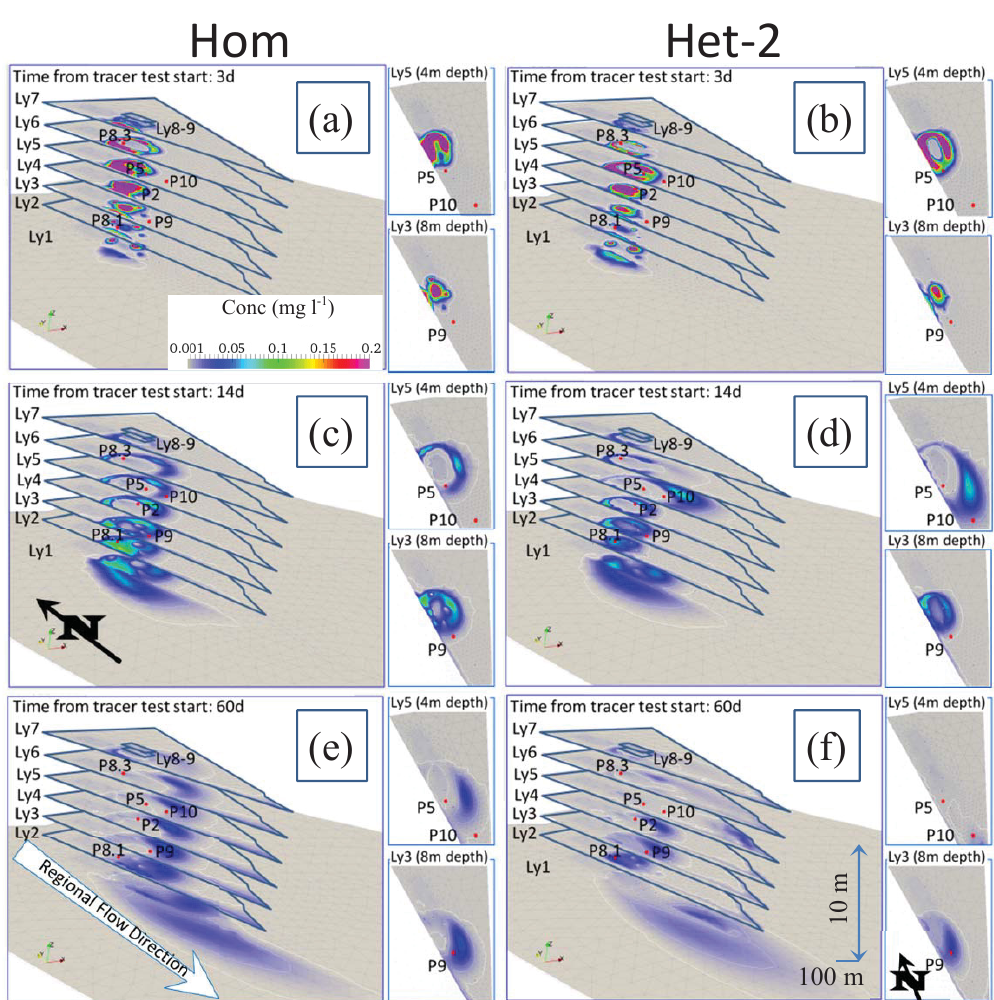
Figure 4. Distribution of amino-G acid concentration at three time points (3d, 14d, and 60d) since the test started, calculated with the Hom ( a , c , and e ) and Het-2 ( b , d , and f ) models. The concentrations in layers 3 and 5 (Ly3 and Ly5 in the figure) are shown from below on the side of each frame. Note that the vertical scale is 100 times the horizontal